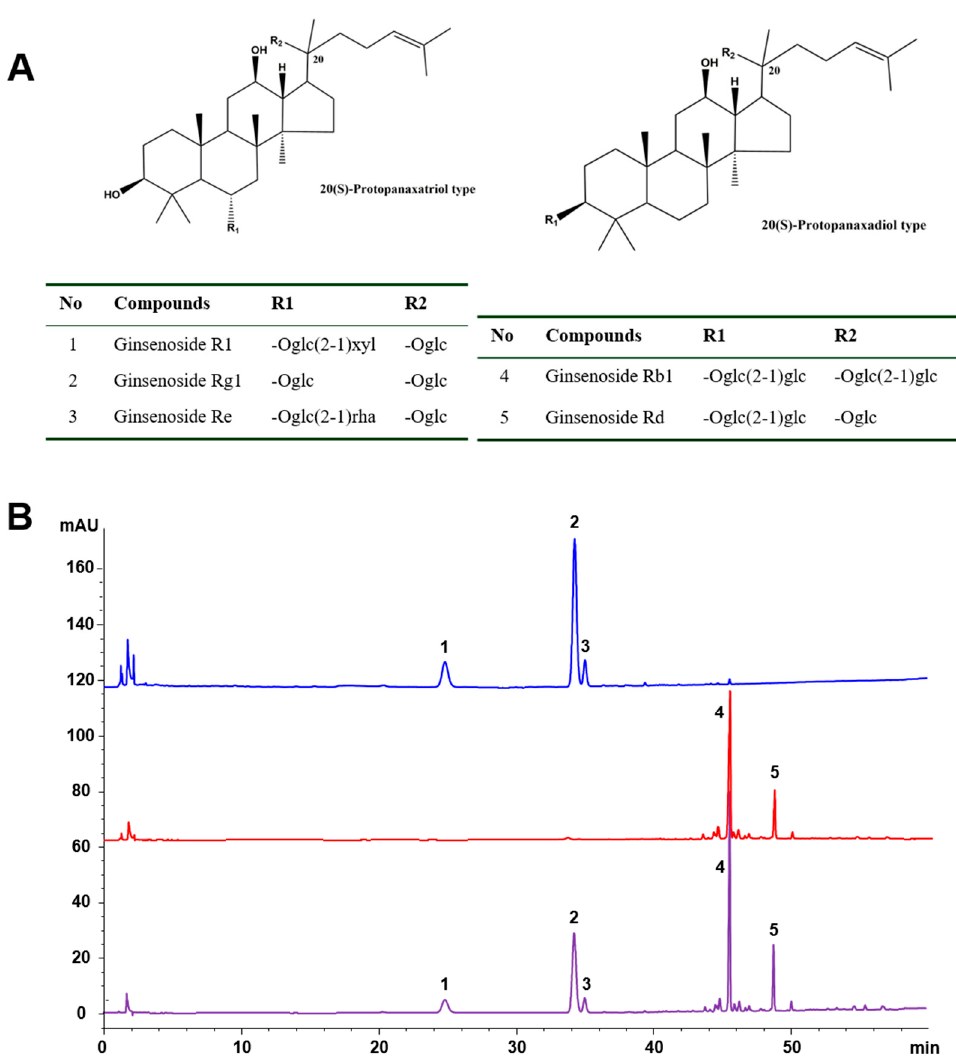
Figure 1. ( A ) Chemical structures of the main saponins in P. notoginseng , and ( B ) the HPLC-UV profiles of 20( S )-protopanaxatriol saponins (PTS), 20( S )-protopanaxadiol saponins (PDS), and Panax notoginseng saponins (PNS). 1, notoginsenoside R1; 2–5, ginsenosides Rg1, Re, Rb1, and Rd, respectively.